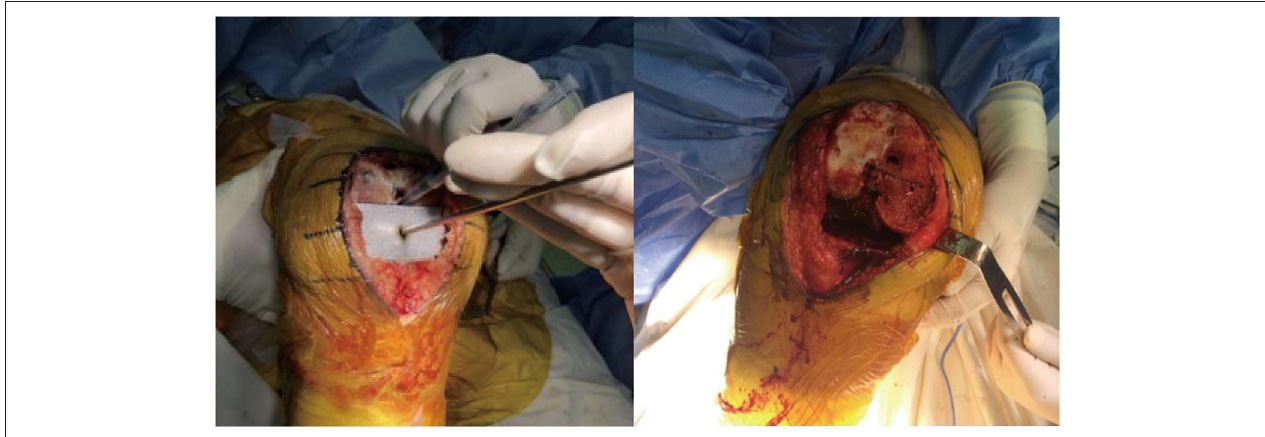
FIGURE 1 | The matching rectangle is used to record the line, and the external osteotomy angle of the femoral posterior condyle is adjusted according to this scribe line with a gap balance technique.